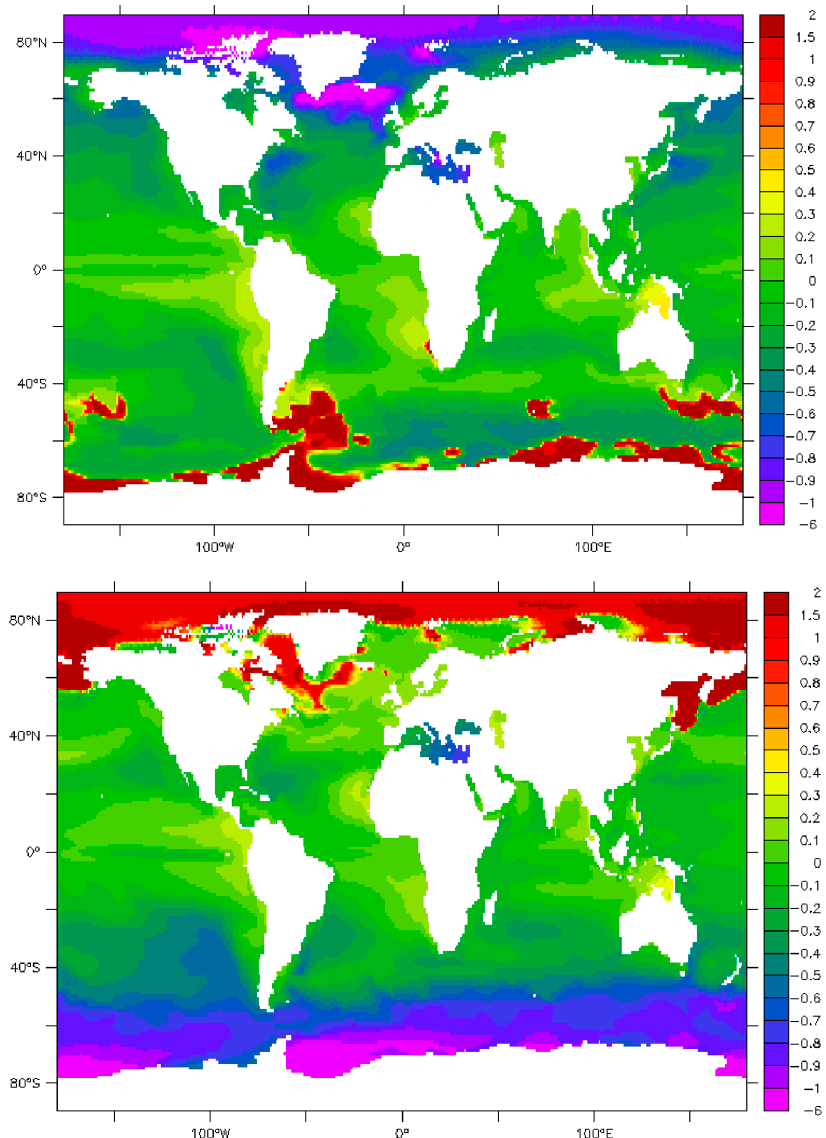
Figure 2. Log surface pressure maps ( Δ tension) constructed as in Figure 1, but with protein (or lipid) levels lowered (or raised) by a factor of three. The color bar has been set so that a reference range of 0.3–3 mN/m is central ( − 0.5 to 0.5 in log units). February and August monthly averages are shown for a typical year near the turn of the millennium.